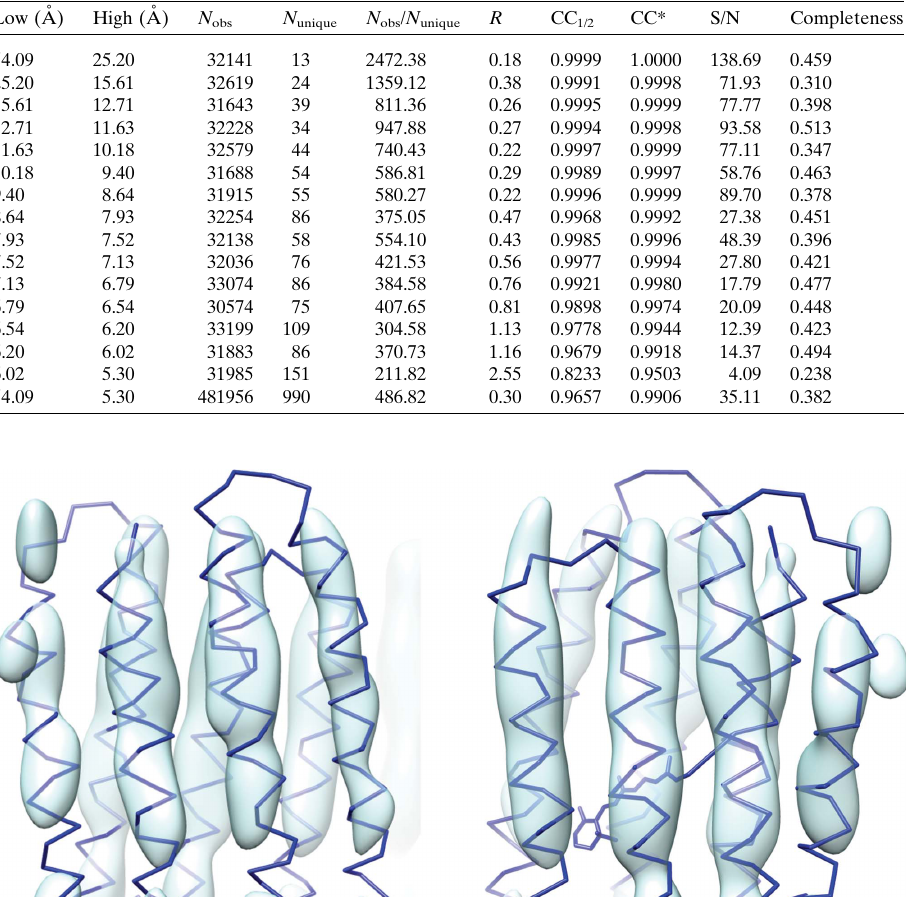
Table 2 Data-processing statistics in three-dimensional resolution bins. Columns 1 and 2, resolution range; column 3, number of observations; column 4, number of unique reflections; column 5, ratio of the two previous columns; columns 6–10, merging R value, half-data-set correlation coefficient (CC 1/2 ), CC*, signal-to-noise ratio (S/N) and completeness as defined in Section 4.